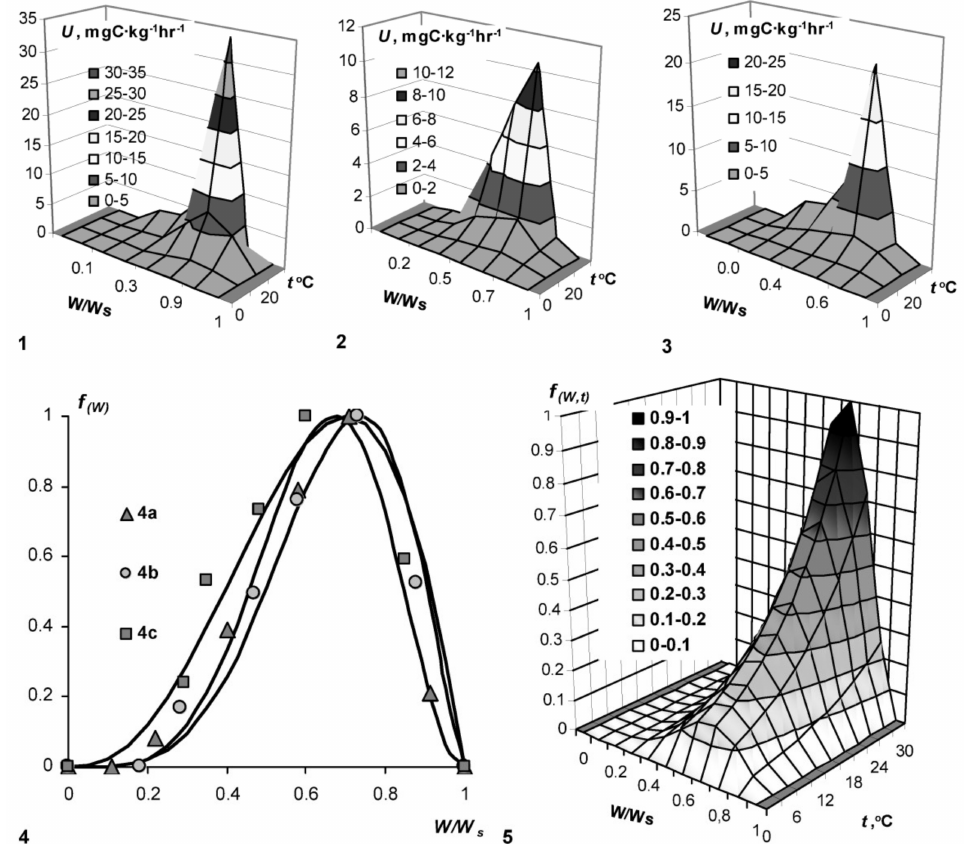
Figure 1. Quantification and modeling of decomposition rate of organogenic substrates (U) as a function of temperature ( t ) and relative humidity ( W / W s ). 1—peat (10 cm), Tver region, 2—peat (100 cm), Tomsk region, 3—peat (10 cm), Moscow region; 4—model (11): 4a—peat (100 cm), 30 ◦ C, Tver region, f ( W ) = ( W / W s /0.67) 4.84 {(1 − W / W s )/(1 − 0.67)} 2.35 ; R 2 = 0.96, s = 0.07; 4b—peat (100 cm), 5 ◦ C, Tomsk region, f ( W ) = ( W / W s /0.74) 4.27 {(1 − W / W s )/(1 − 0.74)} 1.53 ; R 2 = 0.99, s = 0.03 4c—peat (10 cm), 20 ◦ C, Moscow region, f ( W ) = ( W / W s /0.70) 2.54 {(1 − W / W s )/(1 − 0.70)} 1.09 ; R 2 = 0.99, s = 0.04; 5—model (12), peat (100 cm), Tver